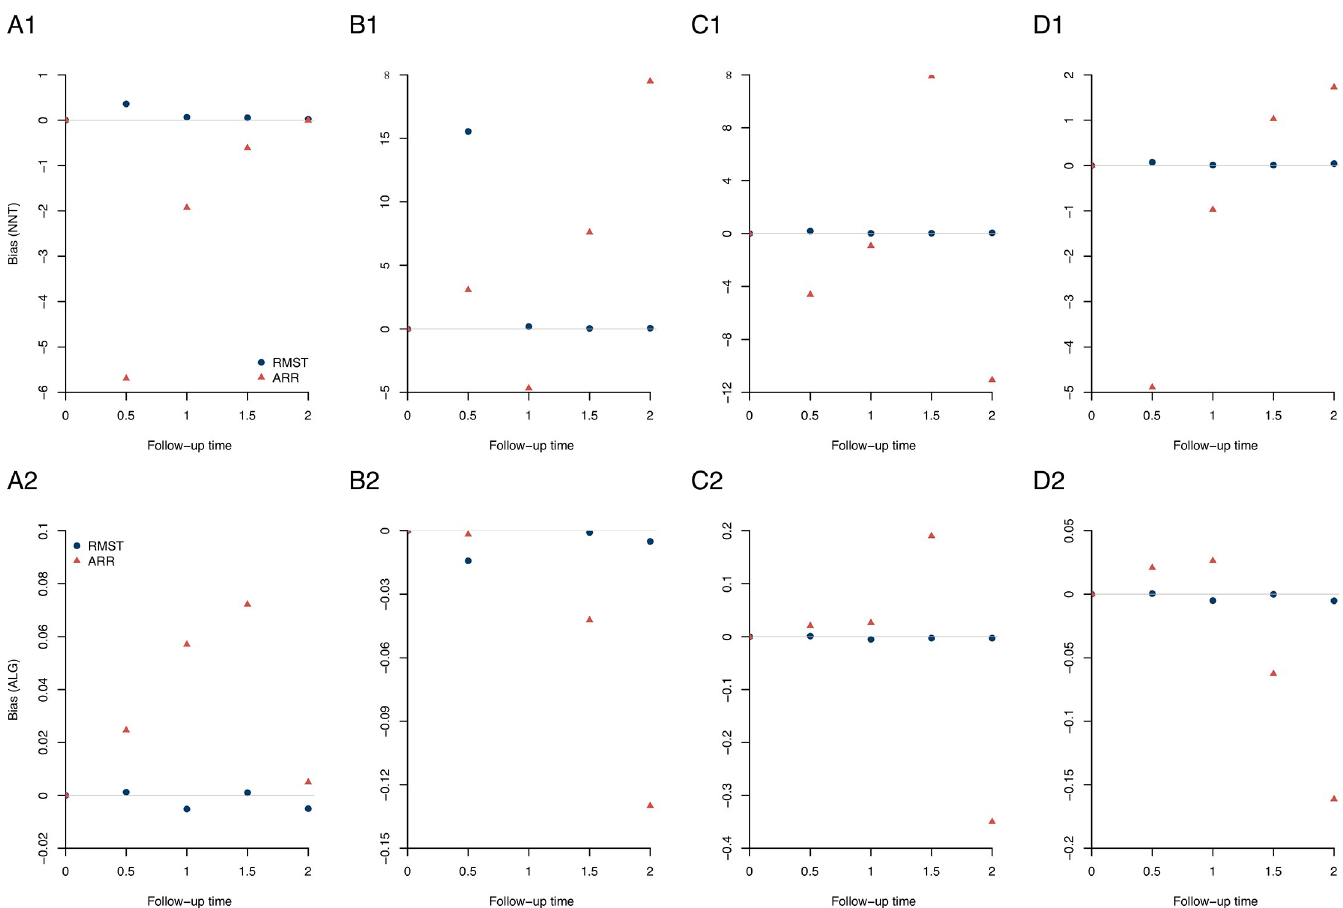
Fig 5. Simulation results of NNT RMST and NNT ARR under four hypothetical scenarios. The upper panel presents the bias of NNT at different time points, and the lower panel shows the bias of the ALG at different time points. (A1-2) Scenario 1: Survival curves with an increasing treatment effect over time; (B1-2) Scenario 2: Survival curves converge at the end of the follow-up; (C1-2) Scenario 3: Survival curves cross during the follow-up period; (D1-2) Scenario 4: Survival curves with a mixture of short- and long- term effects.